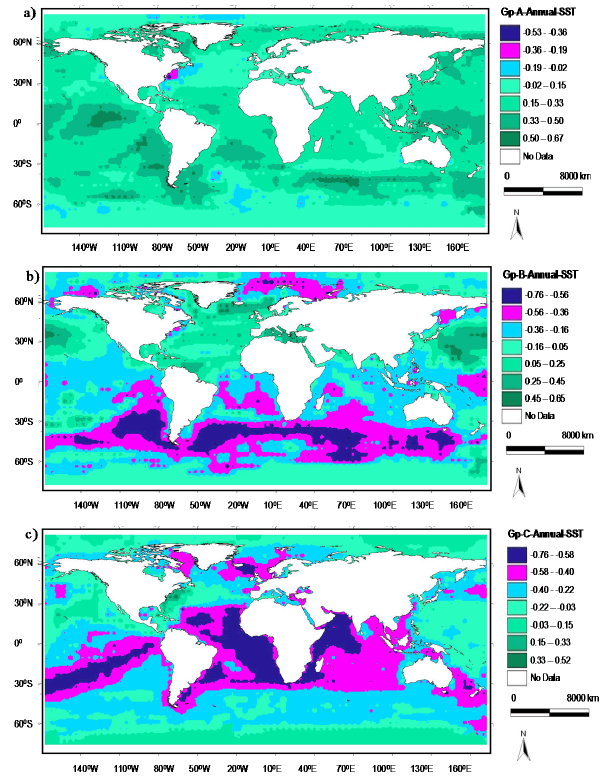
Figure 6. Correlation between annual sea surface temperature (SST) and that in region-wide annual rainfall for group (a) A, (b) B, (c) C. In the legend, Gp denotes group.